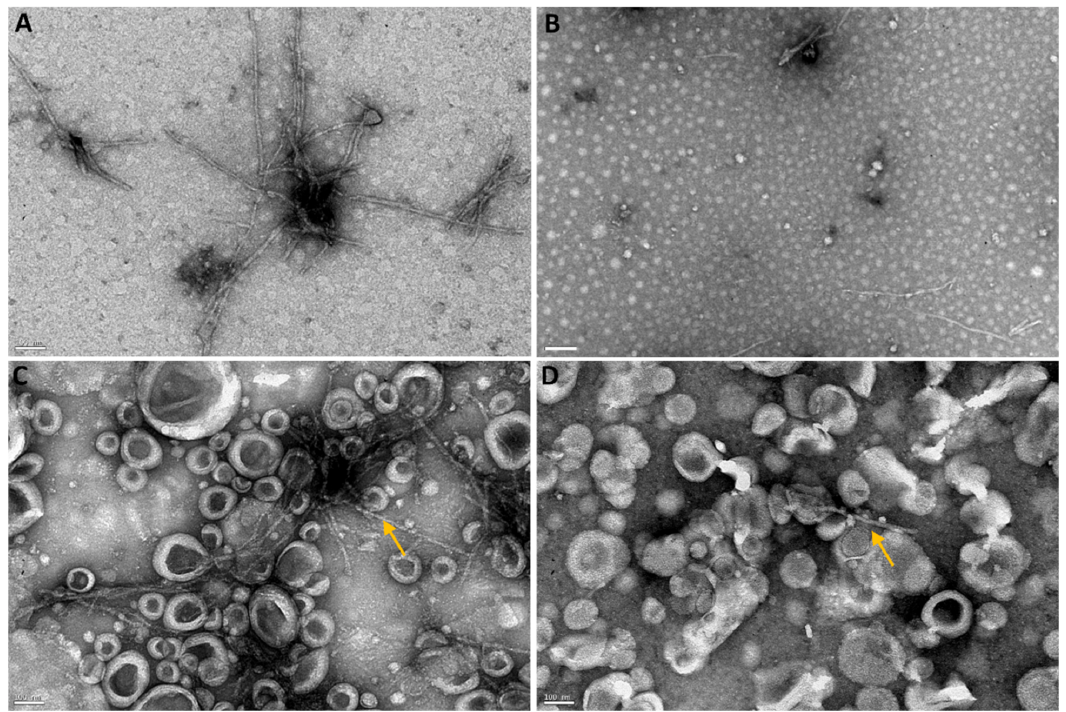
Figure 9. TEM images of ( A ) A β fibrils incubated with ( B ) GA, ( C ) Tf-functionalized liposomes, or ( D ) GA-loaded Tf-functionalized liposomes for 3 h at 37 ◦ C. Yellow arrows show A β fibrils. Scale bars are 100